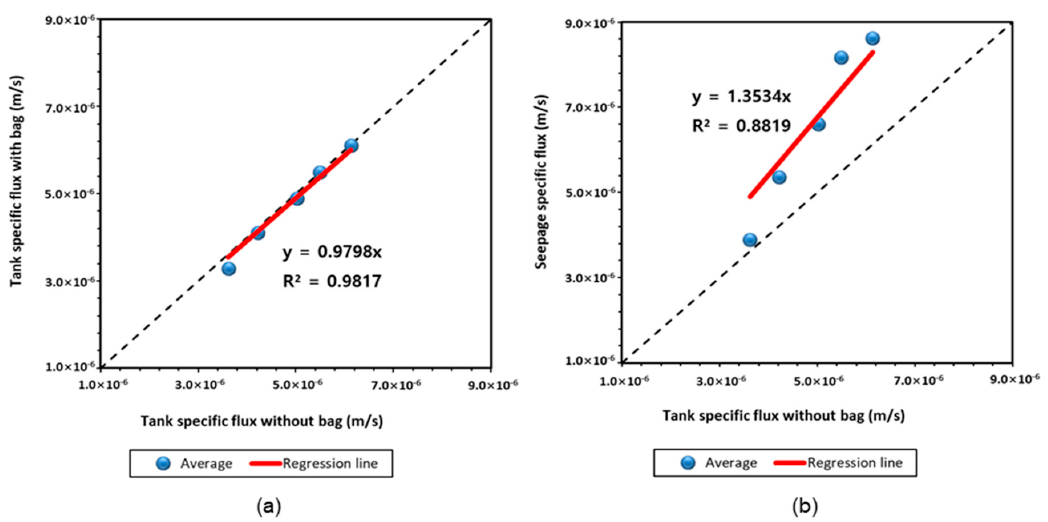
Figure 6. Comparison of ( a ) the tank specific outflux rates with and without the collection bag and ( b ) the tank specific outflux rate and the seepage specific outflux rate measured using the Type 1 collection bag. Error bars represent the standard deviations for five experiments at each pumping rate (see Table 4).